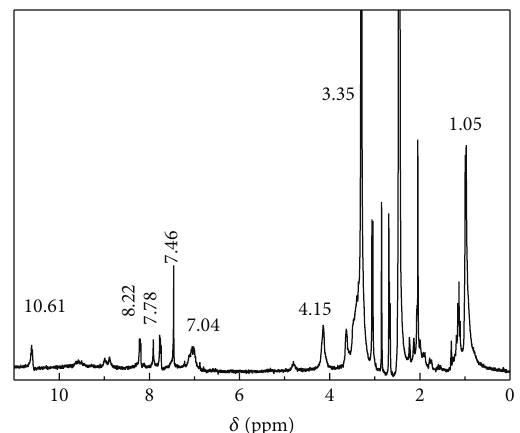
Figure 2: The 1 H-NMR (DMSO-d 6 ) spectrum of